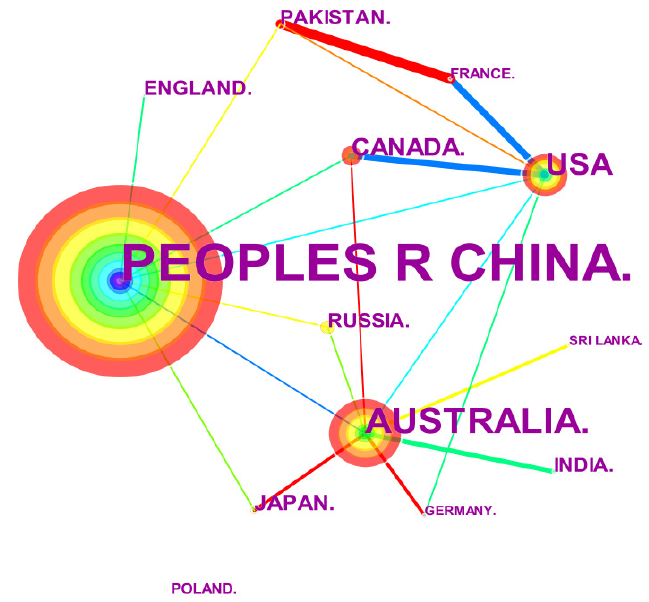
Figure 5. Country cooperation network.